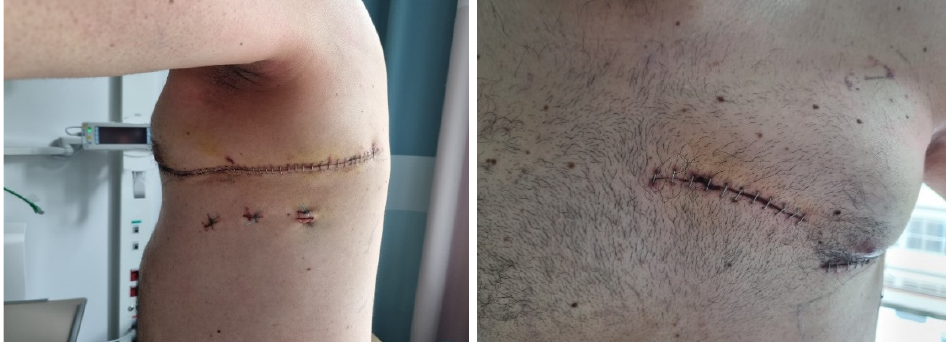
Figure 4. Antero-lateral incision with three chest tube puncture sites (left image). The right image depicts the incision where the nail was removed from the 4th intercostal space of the left hemi-thorax.